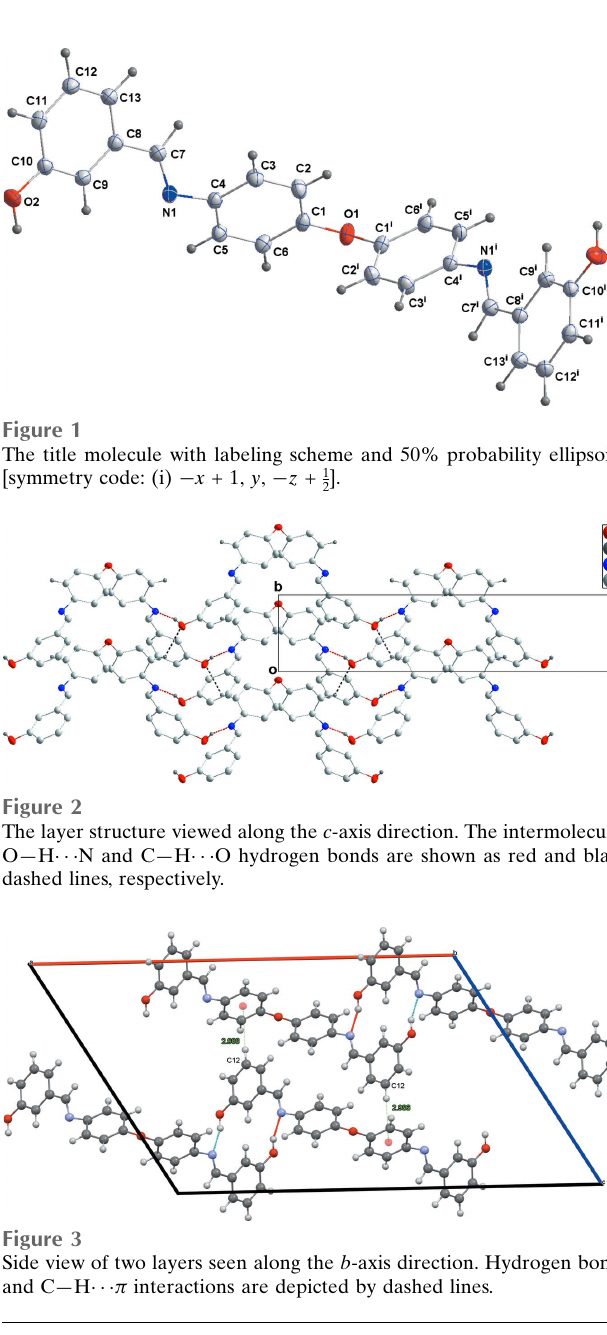
(Table 1, Fig. 2). The layers are hold together by C—H (cid:2) (cid:2) (cid:2) (cid:2) contacts (Table 1, Fig. 3) and by other van der Waals inter- actions (Table 2).